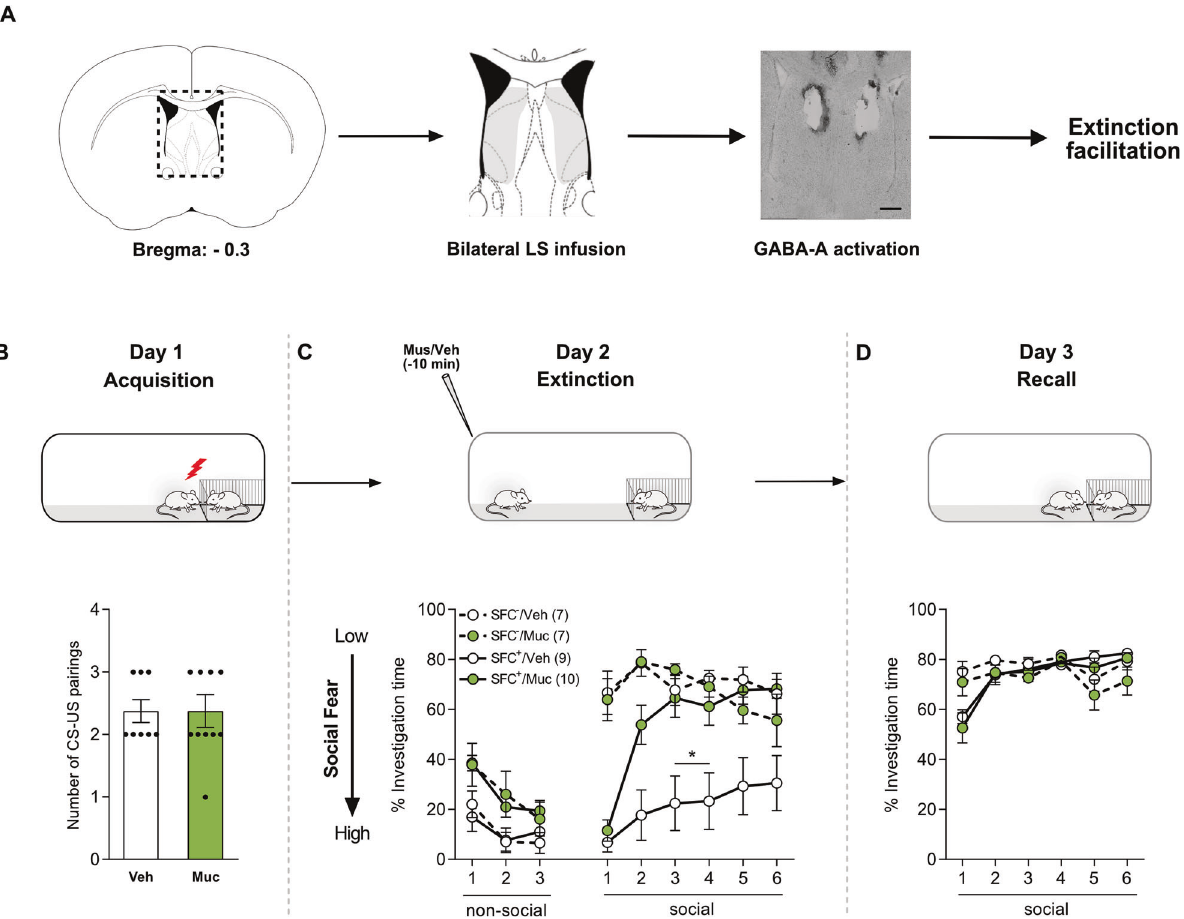
Fig. 4 Activation of GABA-A receptors within the lateral septum (LS) facilitates social fear extinction. Schematic representation of LS, including pharmacological intervention. Scalebar indicates 200 µm and infusions within the highlighted area were considered as correct cannula placements ( A ). The number of CS-US pairings of both groups of conditioned (SFC + ) mice during social fear acquisition on day 1 ( B ). SFC + and unconditioned (SFC − ) mice were bilaterally infused with vehicle (Veh; 0.5% DMSO in sterile Ringer; 0.2 µl/hemisphere) or Muscimol (Muc; 0.2 µg/0.2 µl/hemisphere) 10 min prior to extinction. The percentage of investigation time of three non-social (empty cages) and six social (cage with a conspeci fi c) stimuli was measured during social fear extinction (day 2; C ) and social fear extinction recall (day 3; D ) in SFC − and SFC + mice. Data represent mean CS-US pairings ± SEM ( B ) or mean percentage investigation time ± SEM ( C , D ). * P < 0.05 for SFC + /Muc vs. all other groups ( C social fear expression by HDAC1 within the LS, (iii) an enhanced expression of Gabrb1 in the septum in response to the combination of HDAC1 inhibition and extinction, (iv) facilitation of fear extinction by GABA-A receptor activation, and (iv) long- lasting consolidation of extinction memory after pharmacological inhibition of HDAC1 or activation of GABA-A receptors within the LS. Class I HDACs have been previously associated with social